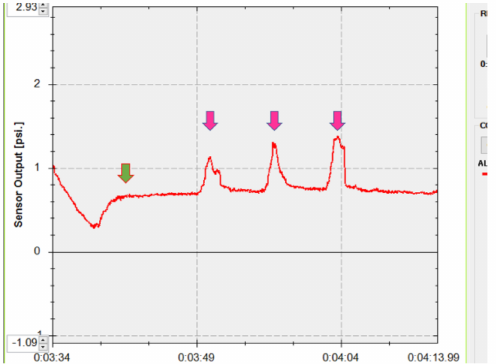
Figure 1. Measurement of the upper eyelid pressure. The patient kept his/her eyes open until the measured pressure became a plateau, which was continued for 5 s (green arrow). Then, the patient closed his/her eyes forcefully three times (pink